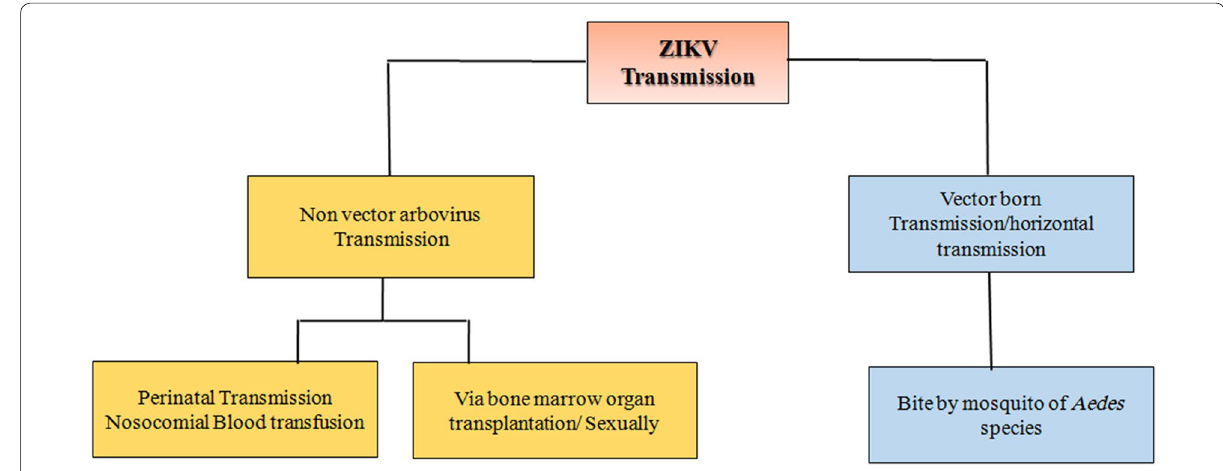
Fig. 3 Schematic diagram representing the transmission of